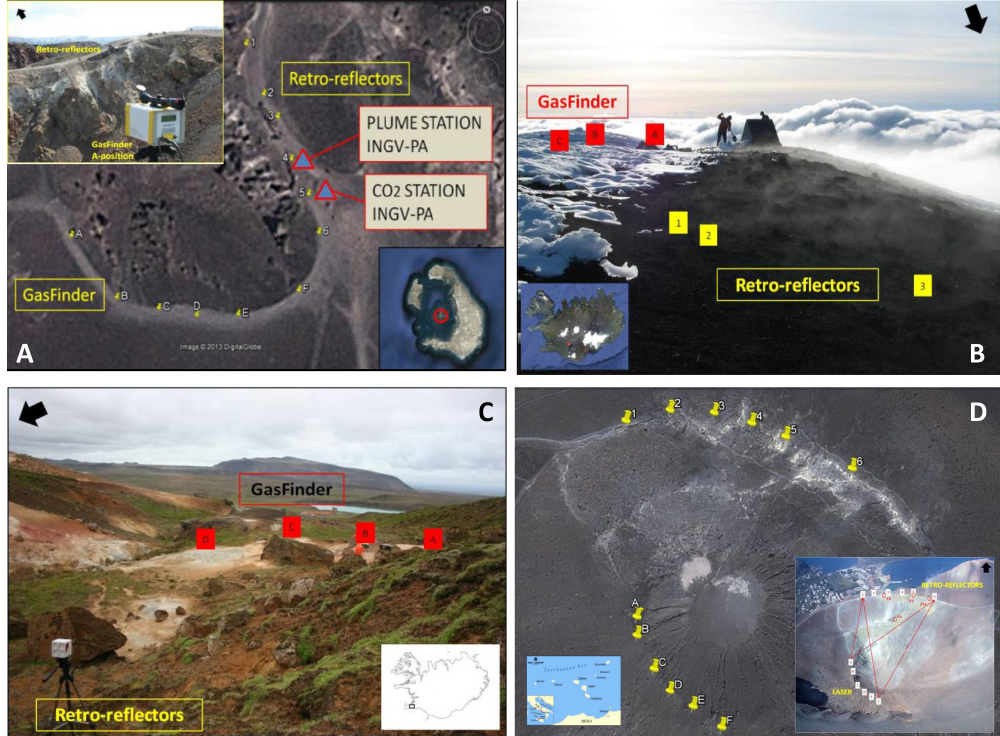
Figure 1. The study areas. (a) Nea Kameni summit crater (Greece), (b) Hekla summit (Iceland), (c) Krýsuvík hydrothermal field, and (d) La Fossa crater (Vulcano Island). In each picture, the positions of GasFinder and retro-reflectors are shown with letters and numbers,